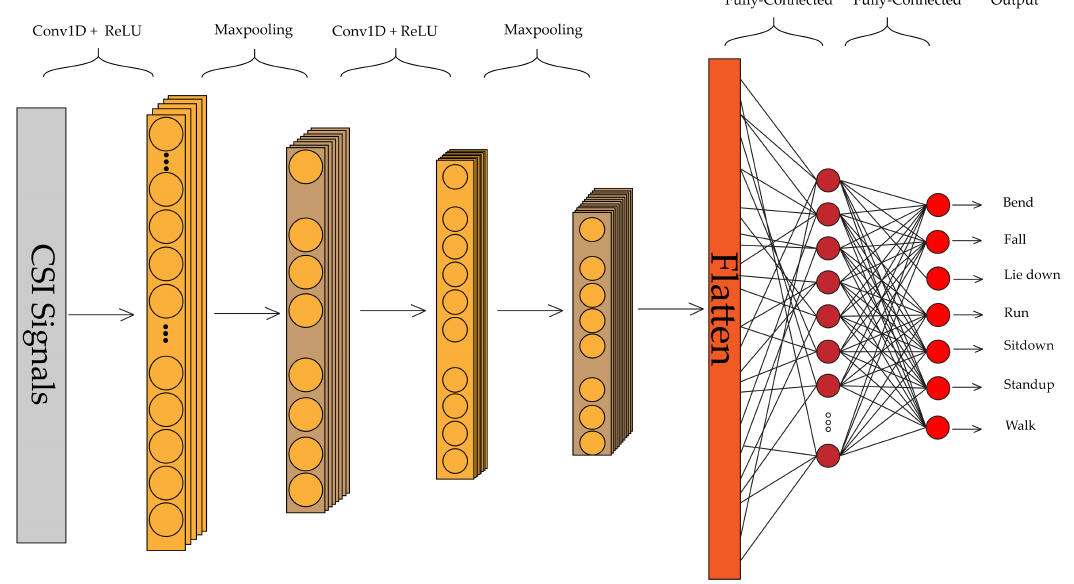
Figure 2. 1D-CNN structure used in this